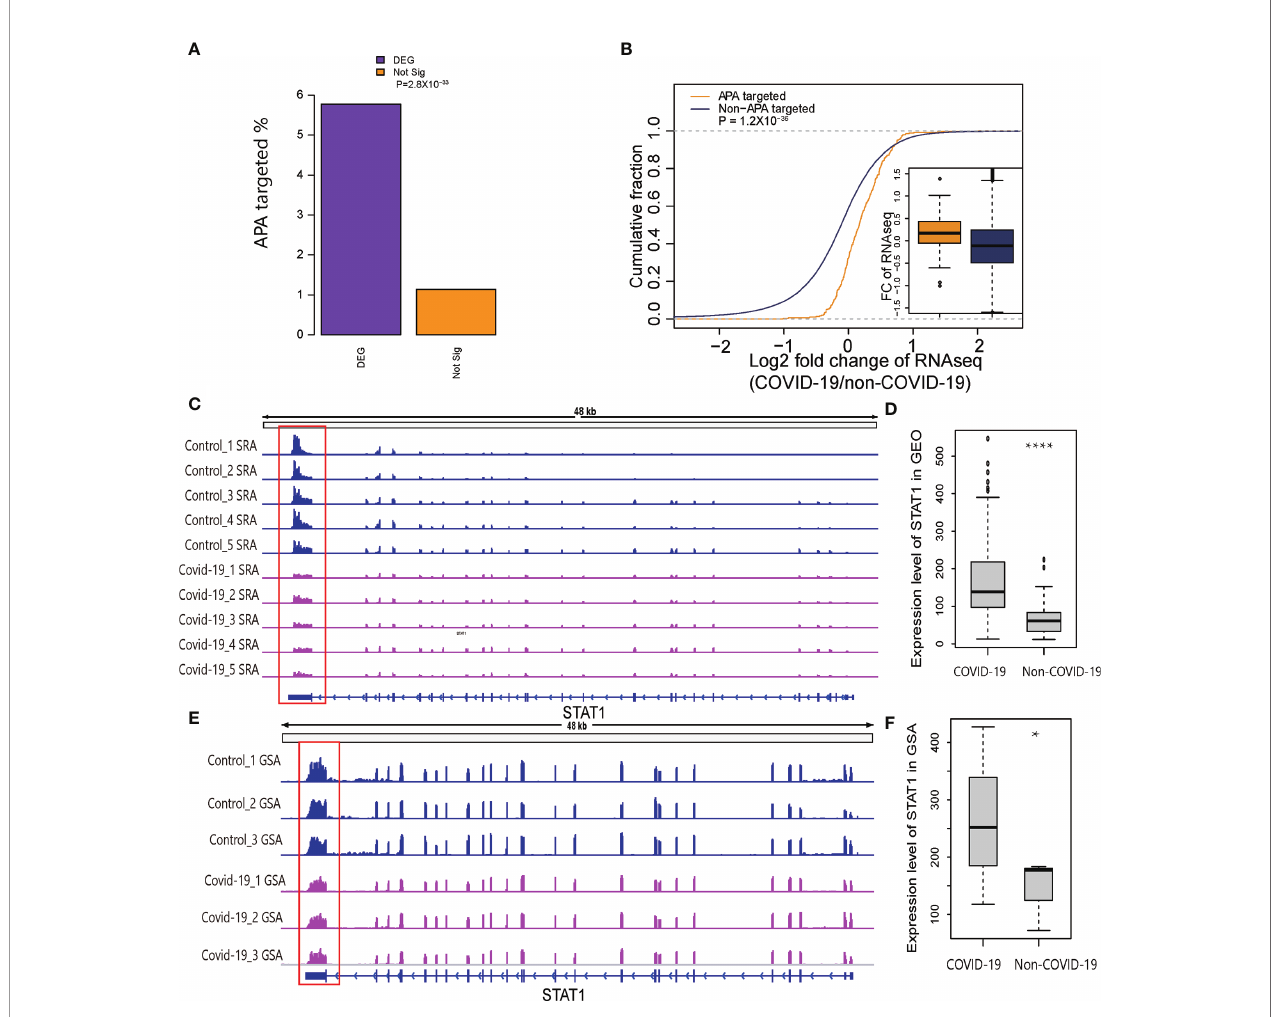
FIGURE 4 | Relationship of APA and DEGs in COVID-19. (A) Barplot representing the percentages of the DEGs or nonsigni fi cant genes enriched for signi fi cant APA sites. (B) Plot of the cumulative fraction of log2-fold change of gene expression ratios in COVID-19 patients comparing genes with signi fi cant APA sites versus those overlapping without signi fi cant APA sites. The p value of a two-tailed Wilcoxon test is indicated. (C) Tracks displaying the read coverage for the STAT1 gene in samples randomly selected from SRP279280. (D) Expression level of STAT1 in COVID-19 and non-COVID-19 patients in GEO. (E) Tracks displaying the read coverage of validation RNA-Seq data (CRA002390) for the STAT1 gene. (F) Expression level of STAT1 in COVID-19 and non-COVID-19 patients in GSA. *P < 0.05, ****P <